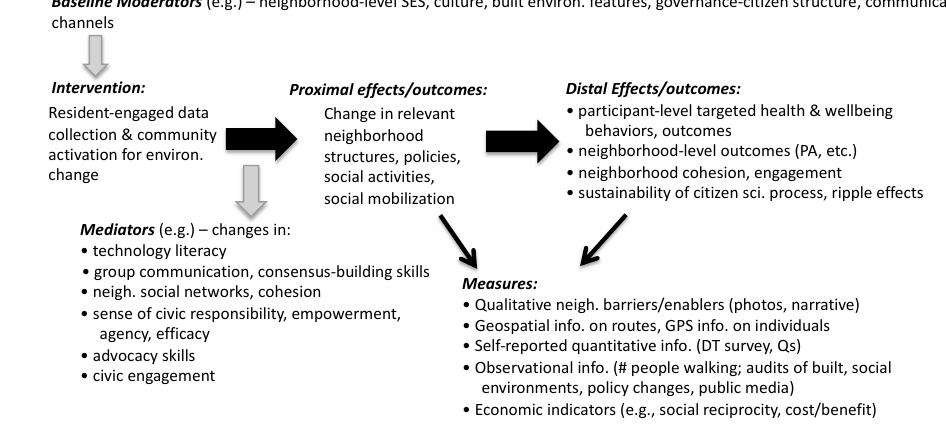
Figure 2. Our Voice research framework.